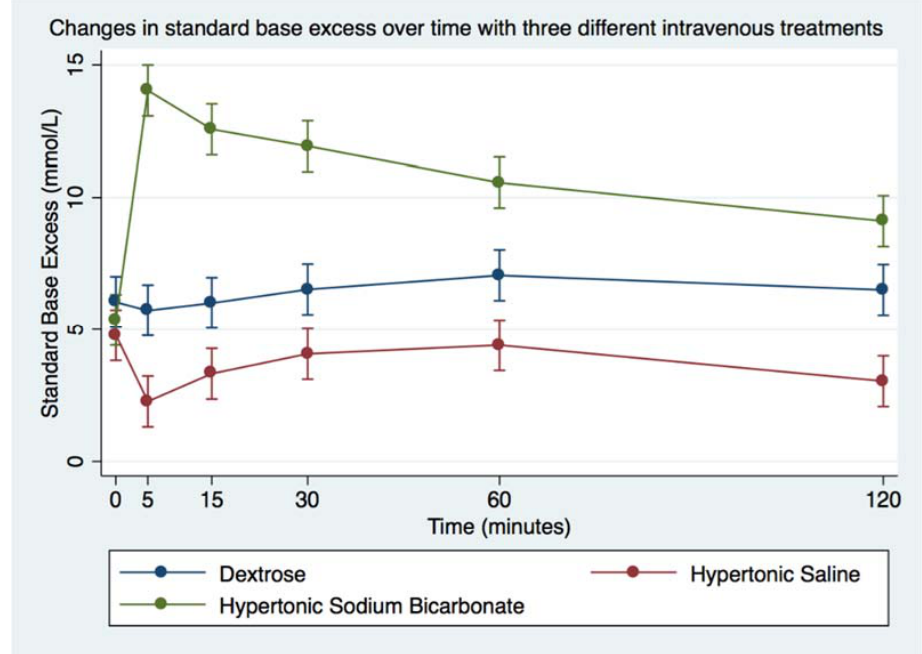
Figure 3. Overall effect of treatment on the blood SBE over time. The mean and SEM venous blood SBE for all six horses. Blue = Treatment Group DS (5% dextrose solution at 2 mL/kg bwt); Green = Treatment Group HB (NaHCO 3 8.4% solution at 2 mmol/kg bwt); and Red = Treatment Group HS (NaCl 7.5% solution at 4 mL/kg bwt).